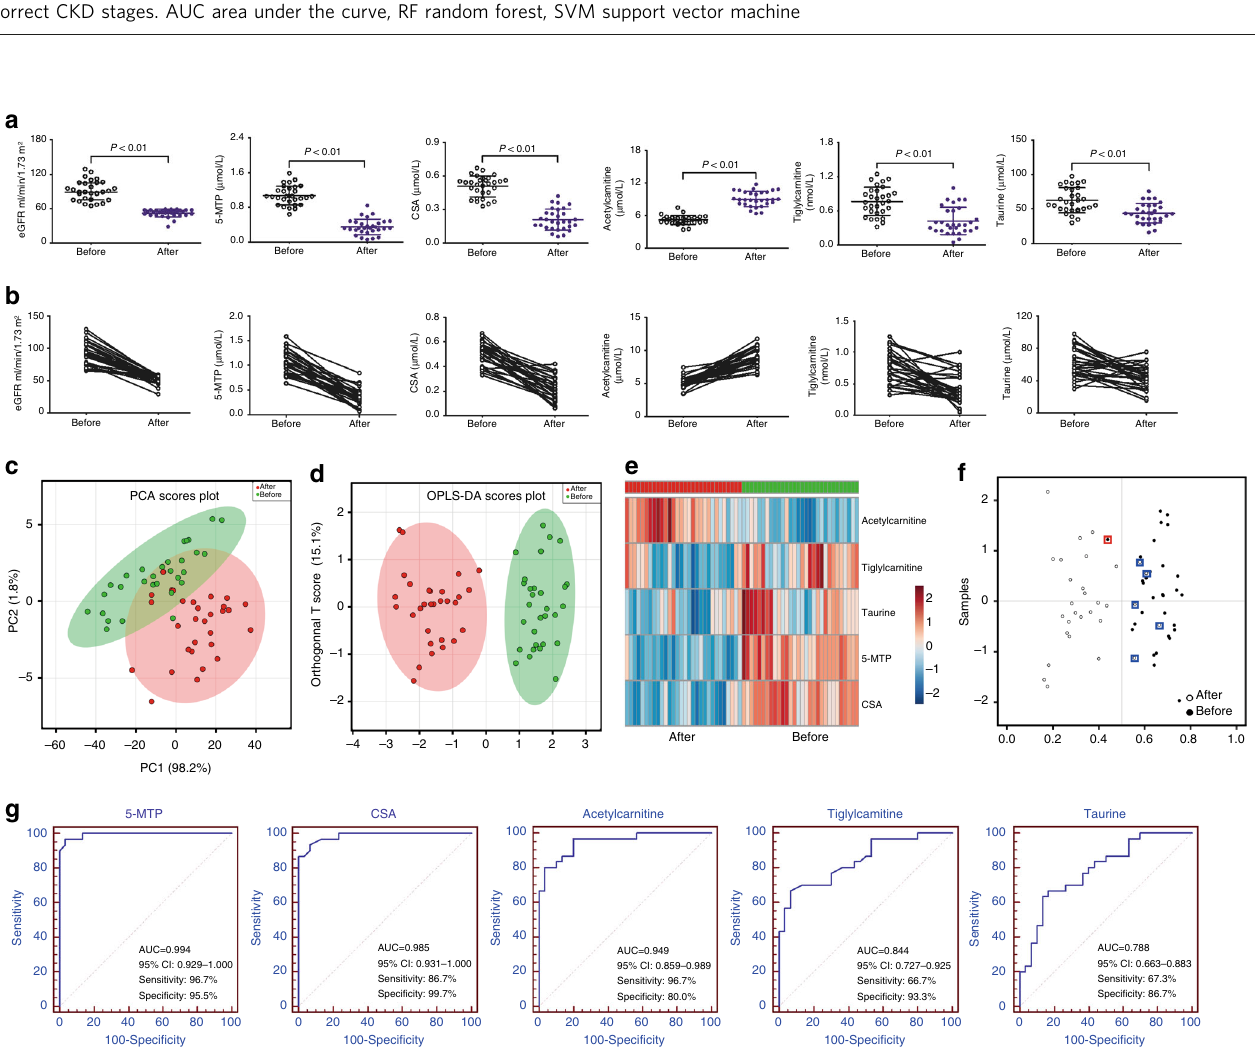
Fig. 2 Multivariate statistical analysis of the metabolites and clinical indexes and external validation. a Heatmap and unsupervised cluster constructed using the fi ve metabolites and two clinical parameters. Strong cluster separation can be observed among CKD stages. All normal healthy controls were clustered together. Subjects with early CKD stages clearly separated from subjects with late CKD stages. Darker color was low abundance, light color was high abundance. b Bar plot demonstrates the accuracy and fi tness of the all models tested. Three evaluation parameters were plotted: Pseudo R 2 , random forest accuracy and support vector machine accuracy. The models with best fi tness and accuracy are the models with the 98 metabolites. We further chose the model of fi ve metabolites with two clinical parameters as our fi nal model. c Confusion matrix of random forest evaluation on the fi nal model. The accuracy was 95.5%. d Confusion matrix of support vector machine evaluation on the fi nal model. The accuracy was 92.0%. e ROC curves of fi ve metabolites and proteinuria in normal healthy controls and all patients with CKD. f Unsupervised cluster results show all 30 normal healthy controls clustered together and separated from patients with CKD. Two outliers were observed between CKD1 and CKD2. Darker color was low abundance, while light color was high abundance. g Scatter plot of PC1 vs PC2, clear separation can be observed between normal healthy controls and patients with